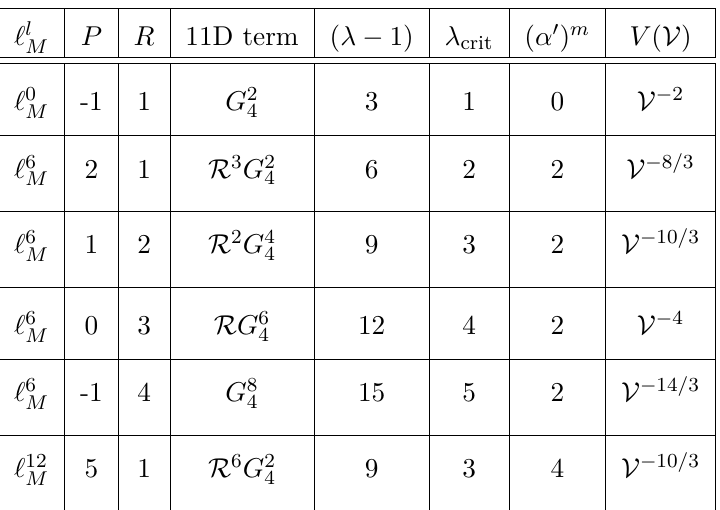
Table 3 . Summary of results for some ( α 0 ) even corrections to the 4D potential at different F- and D-term order from classical reduction of higher derivative M-theory terms in the F-theory limit. For simplicity, we set x = o = 0 in λ because the volume scaling in V ( V ) is independent on crit